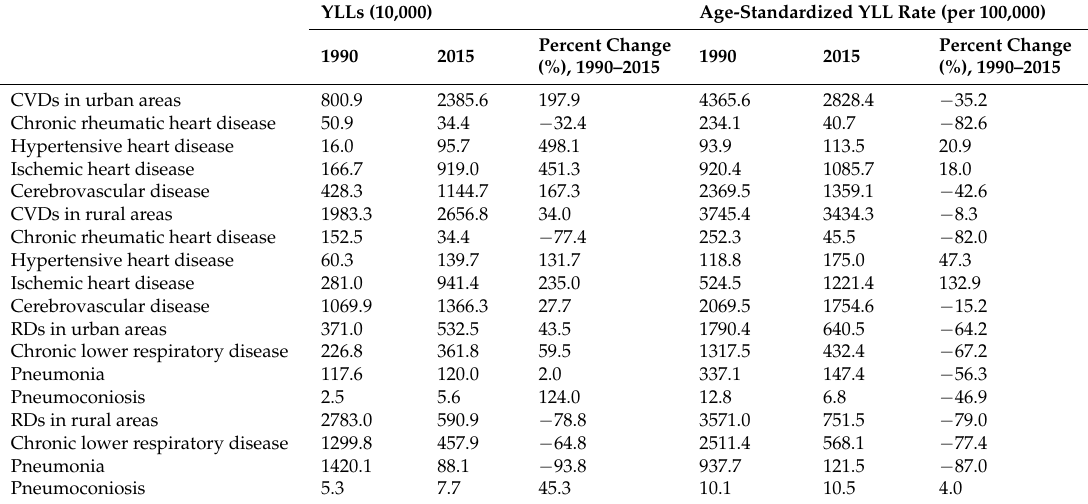
Table 3. YLLs and age-standardized YLL rates from CVDs and RDs for urban and rural areas in 1990 and 2015, with percent change between 1990 and